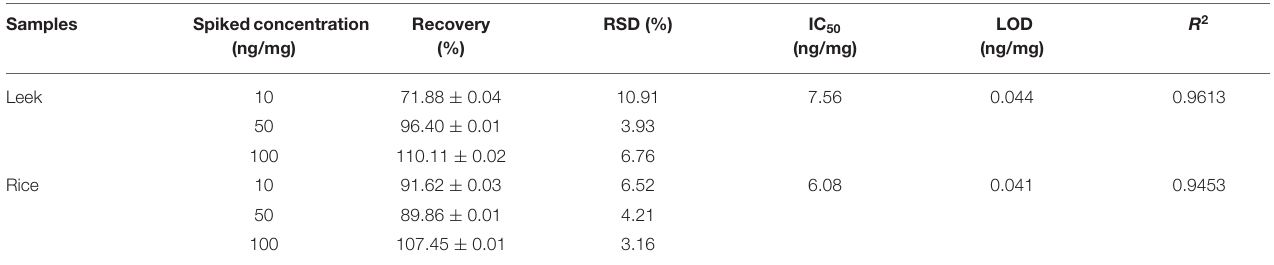
Samples Spikedconcentration